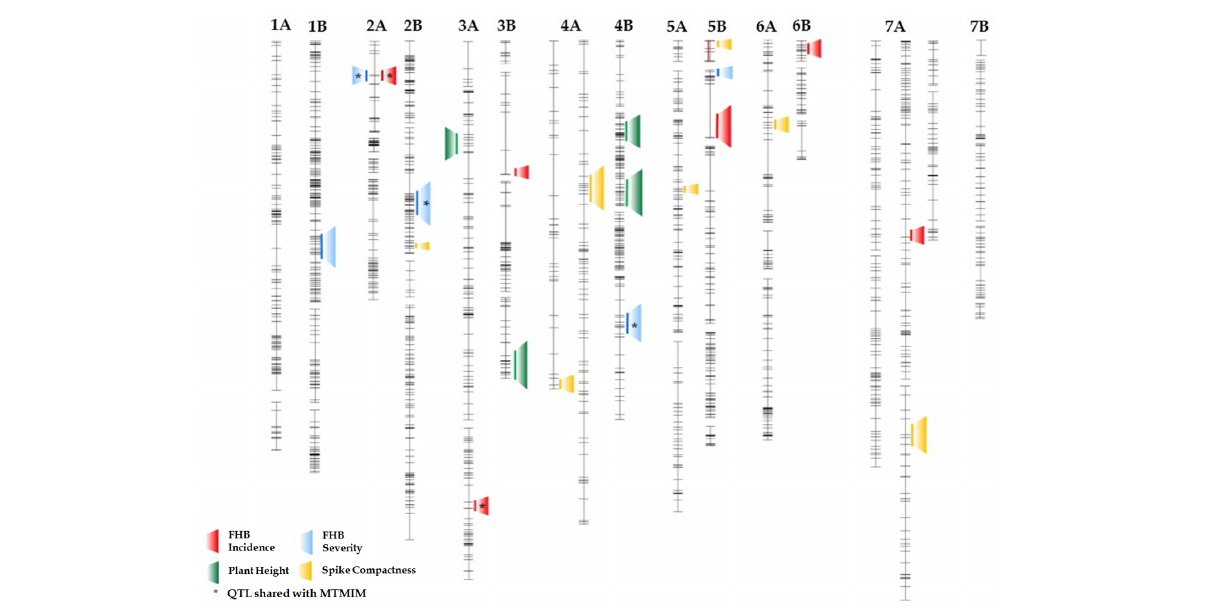
FIGURE 3 | Schematic representation of durum wheat chromosomes reporting mapped QTL (LOD ≥ 3.0) for FHB incidence (red) and severity (blue), for plant height (green) and ear compactness (yellow). The analysis was conducted with Inclusive Interval Composite Mapping (ICIM) in the 135-RIL